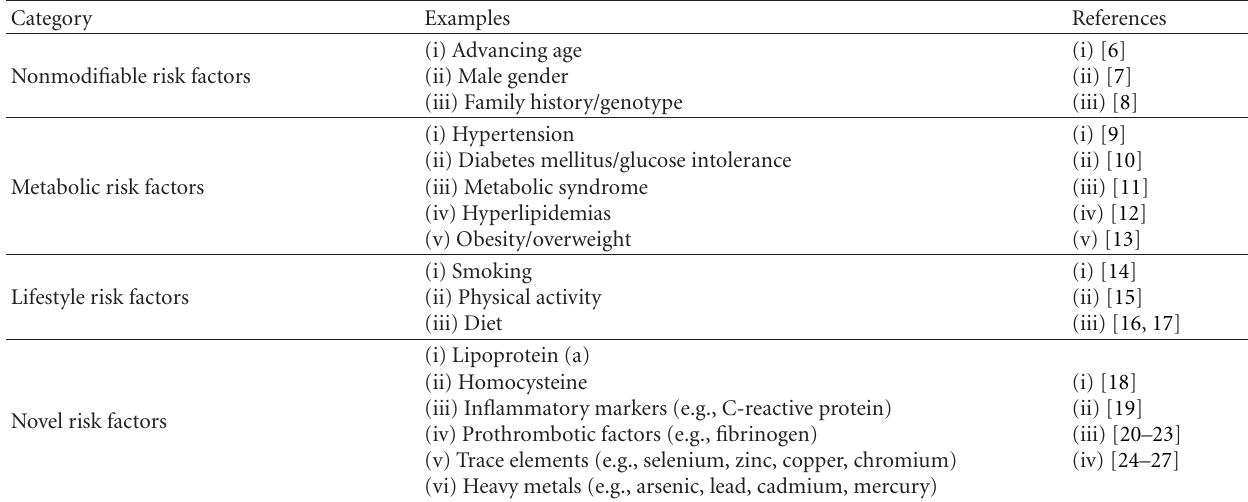
Table 1: Classification of CVD risk